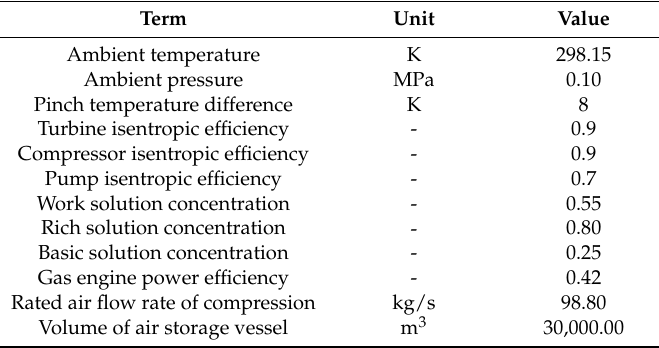
Table 1. The simulation condition of the proposed CAES system.